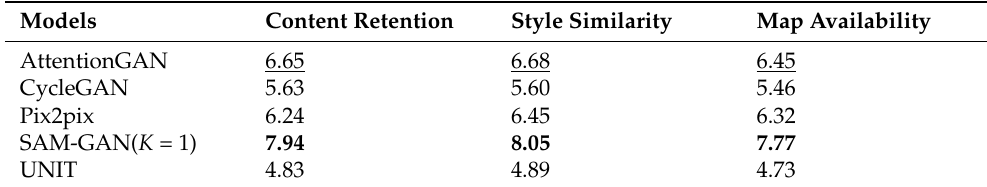
Table 3. Qualitative comparison results between the baseline model and SAM-GAN on the performance of aerial image-to-map translation. (Bold: performance first; underlined: performance